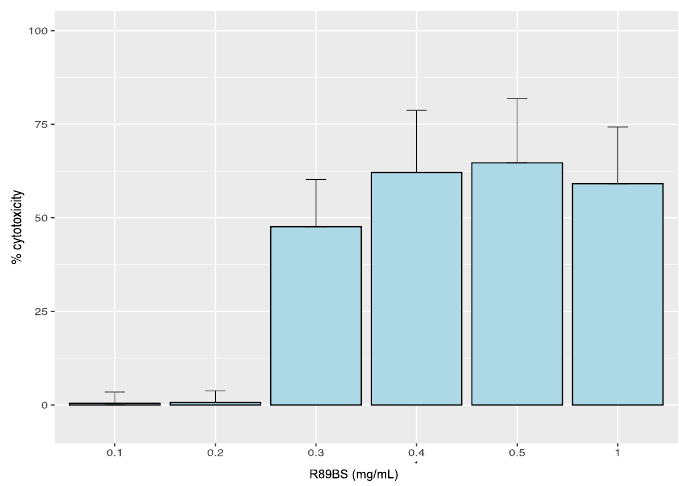
Figure 7. Cytotoxicity of R89BS on human normal lung fibroblasts (MRC5). Cytotoxicity level of different concentrations of R89BS solution. The negative control is represented by cells in standard growth medium, and the positive control is represented by fully lysate cells (0.5% Triton X).